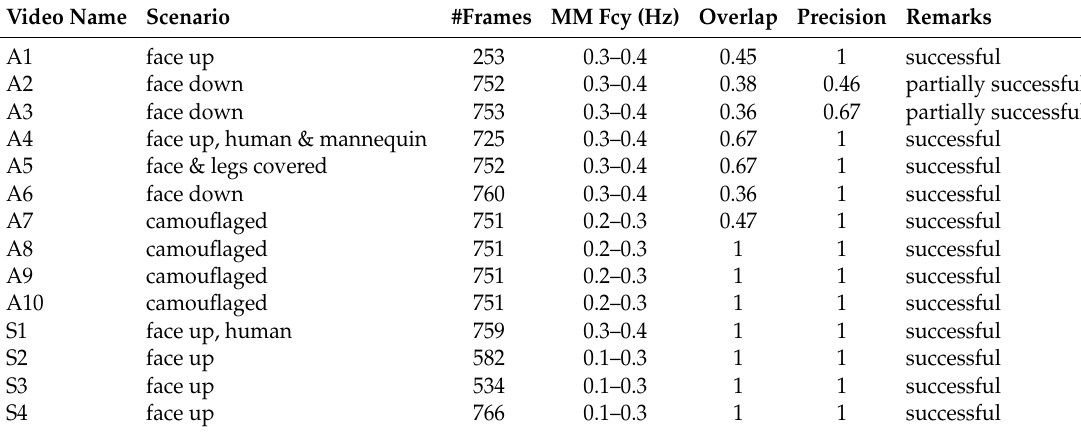
Table 1. A summary of the selected videos and the estimation accuracy. We named the aerial videos from A1 to A6 and stationary videos from S1 to S4. Here, MM Fcy refers to motion magnification frequency. “Scenario” column lists additional remarks to the lying down pose. These results are graphically illustrated in Figures 6 and